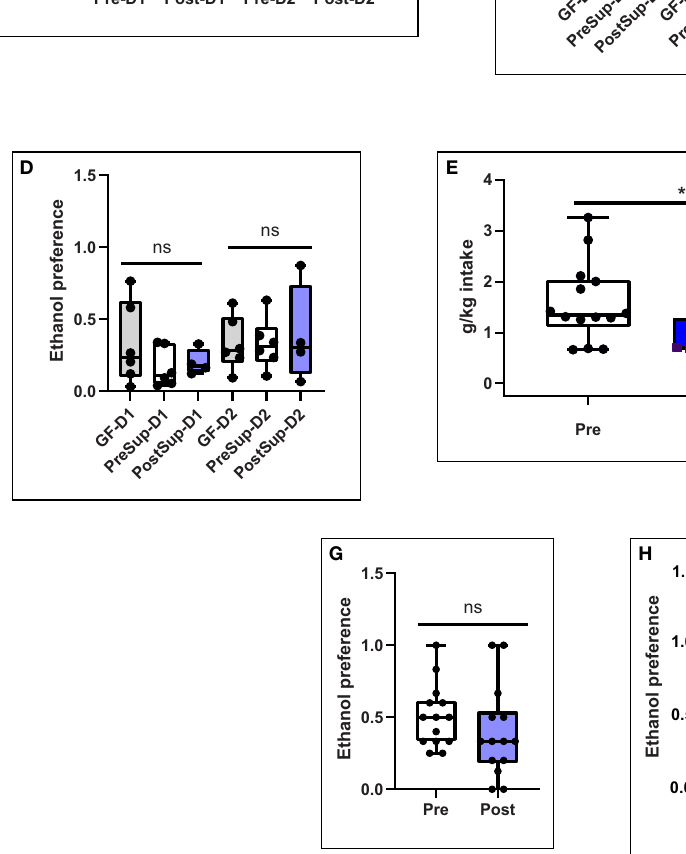
Mann – Whitneytestone-sided), F Germ-freemiceandthosecolonizedusingsterile binge, G Initial alcohol acceptance measured as a 2-h initial binge on day 1 was statistically similar across pre/post-FMT stool or H: between germ-free mice